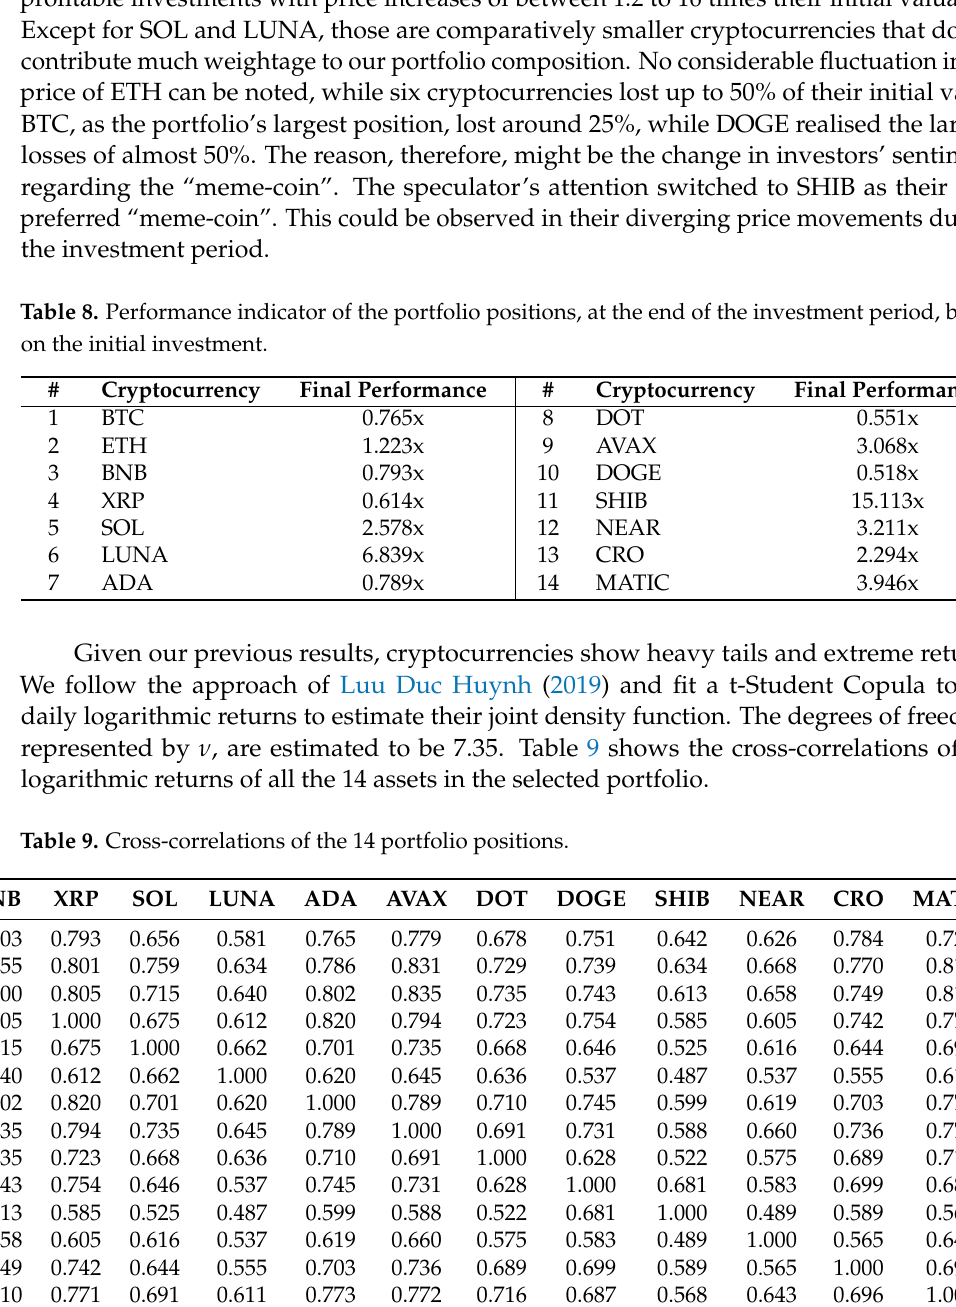
Table 8 highlights the final performance of all portfolio positions over the investment period of 365 trading days. We can observe that, out of the 14 positions, eight have been profitable investments with price increases of between 1.2 to 16 times their initial valuation.